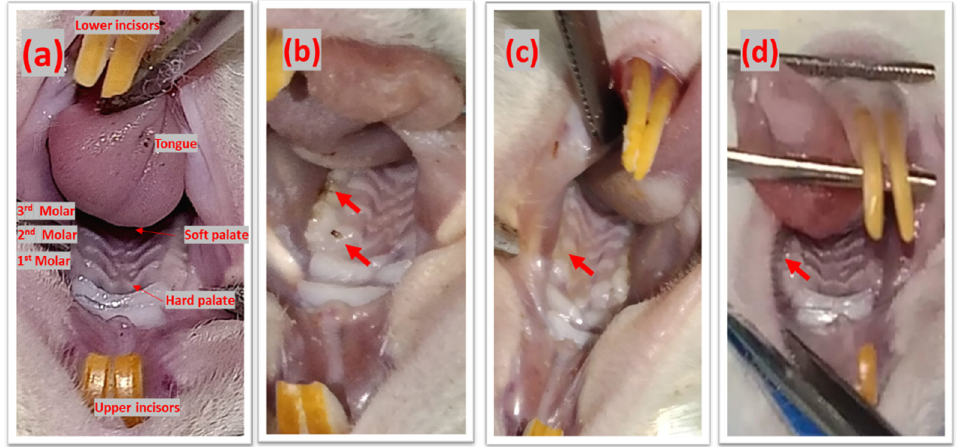
Figure 8. ( a ) Mouth oral cavity, secondary caries assessment, red arrows showing ( b ) marginal caries adjacent to simple composite, ( c ) visual changes in the enamel around the composite with ZnO, and ( d ) sound tooth surface around the restoration composite with Mg-doped ZnO.